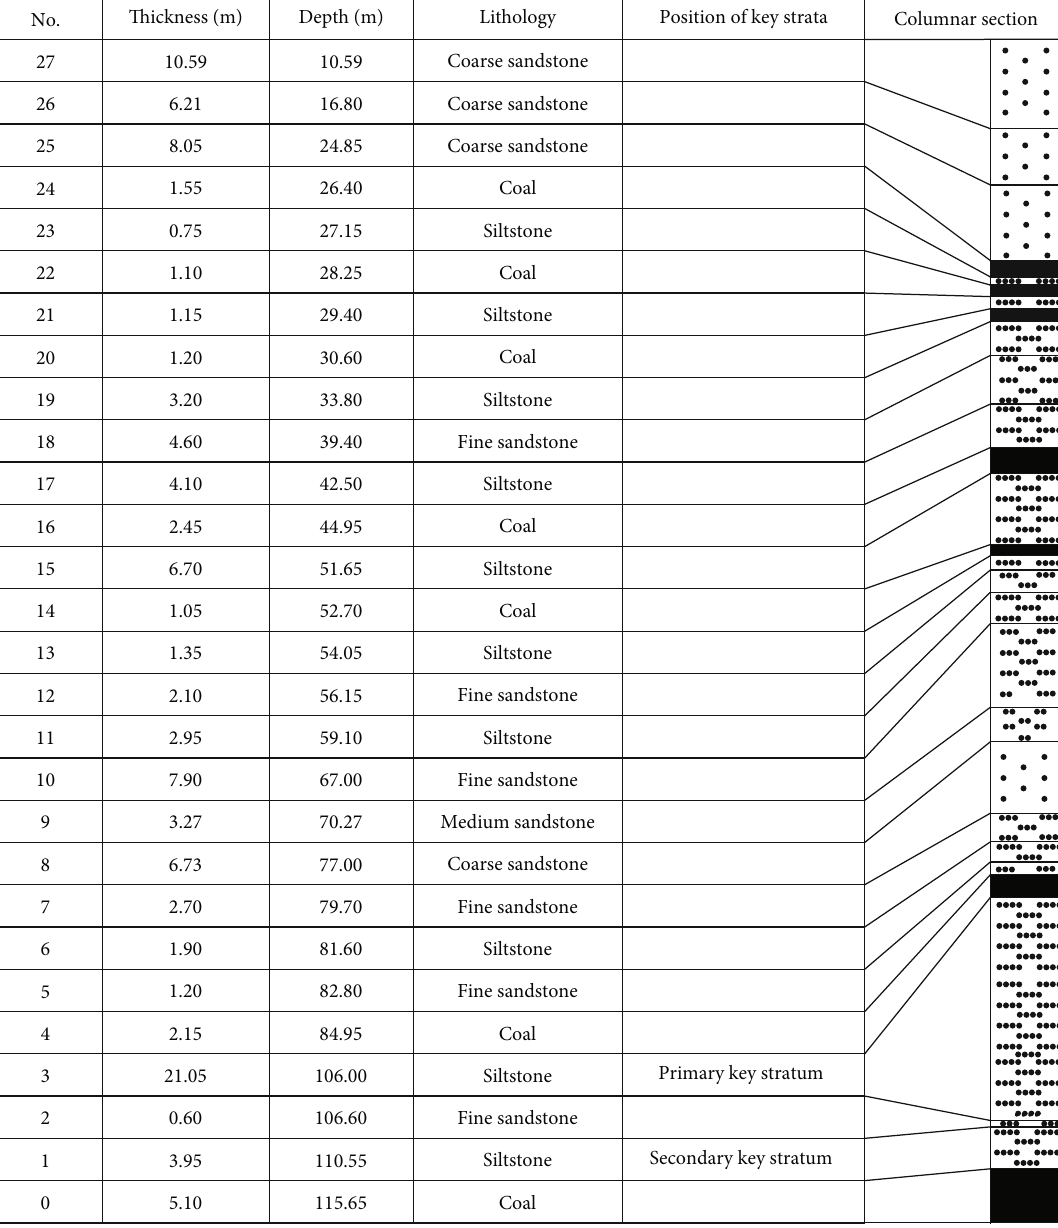
Figure 4: Key strata distinguishing results of ZK1416 borehole.